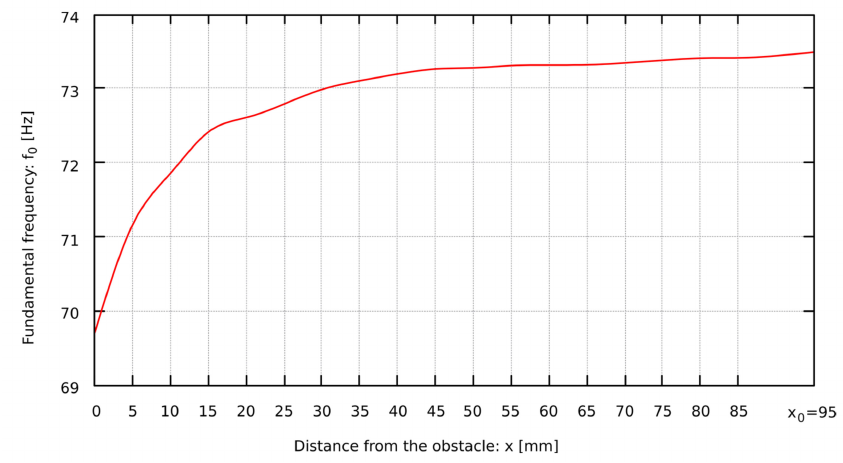
Figure 6. The dependence of the distance of the obstacle from the lips for the Bass Principal 16ft open D. Table 6. Logarithmic regression coefficients and the coefficient of determination for the dependence of the fundamental frequency on the distance between the obstacle and the pipe’s